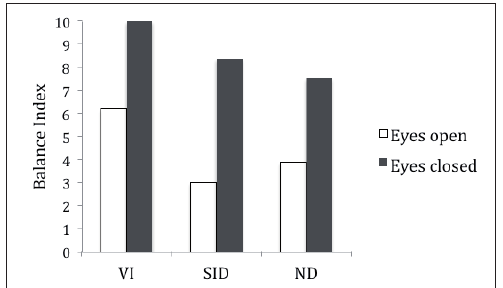
Mean scores of the Balance Index in stance